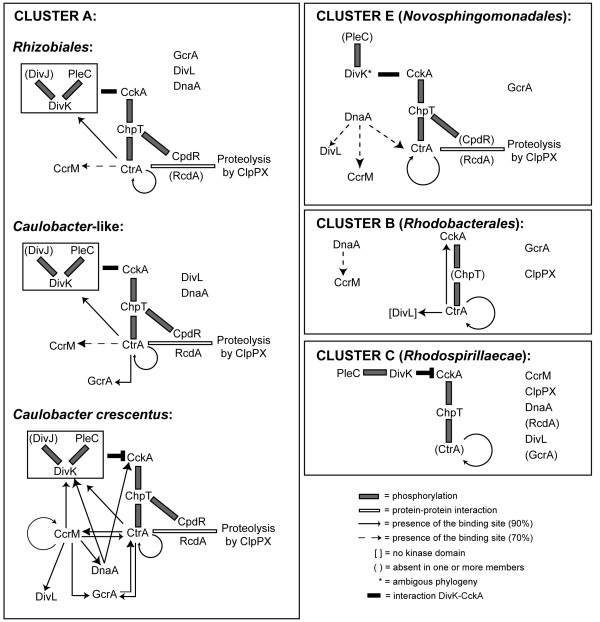
Regulatory circuits of clusters A, B, C, E. See the "Results" and "Discussion" sections for more details. Interactions via phosphorylation, as well as proteolysis, were suggested only considering the interaction demonstrated in Caulobacter. Moreover, DivK inhibition on CckA was considered, as in Biondi (2006), only in Caulobacter [20]. The presence of binding sites of transcription factors CtrA, DnaA and GcrA is shown as a continuous line if predicted binding sites were present in at least 90% of the gene promoters of a cluster. In contrast, the connection is shown as a dotted line for binding sites present in ca. 70%. The Caulobacter-like group corresponds to B. japonicum, P. lavamentivorans and M. maris.